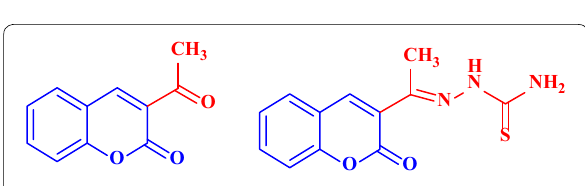
Fig. 75 Molecular structure of compound C88a and